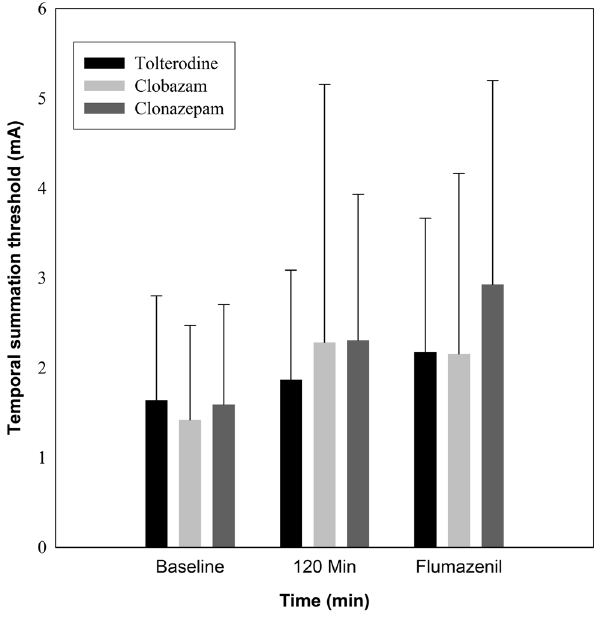
Figure 5. Intramuscular repeated electrical stimulation (5 stimuli). There was a statistically significant increase in the temporal summation thresholds for clonazepam (p=0.021) and clobazam (p=0.021) between baseline measures and 120 minutes, whereas no statistically significant change in threshold after the active placebo tolterodine was